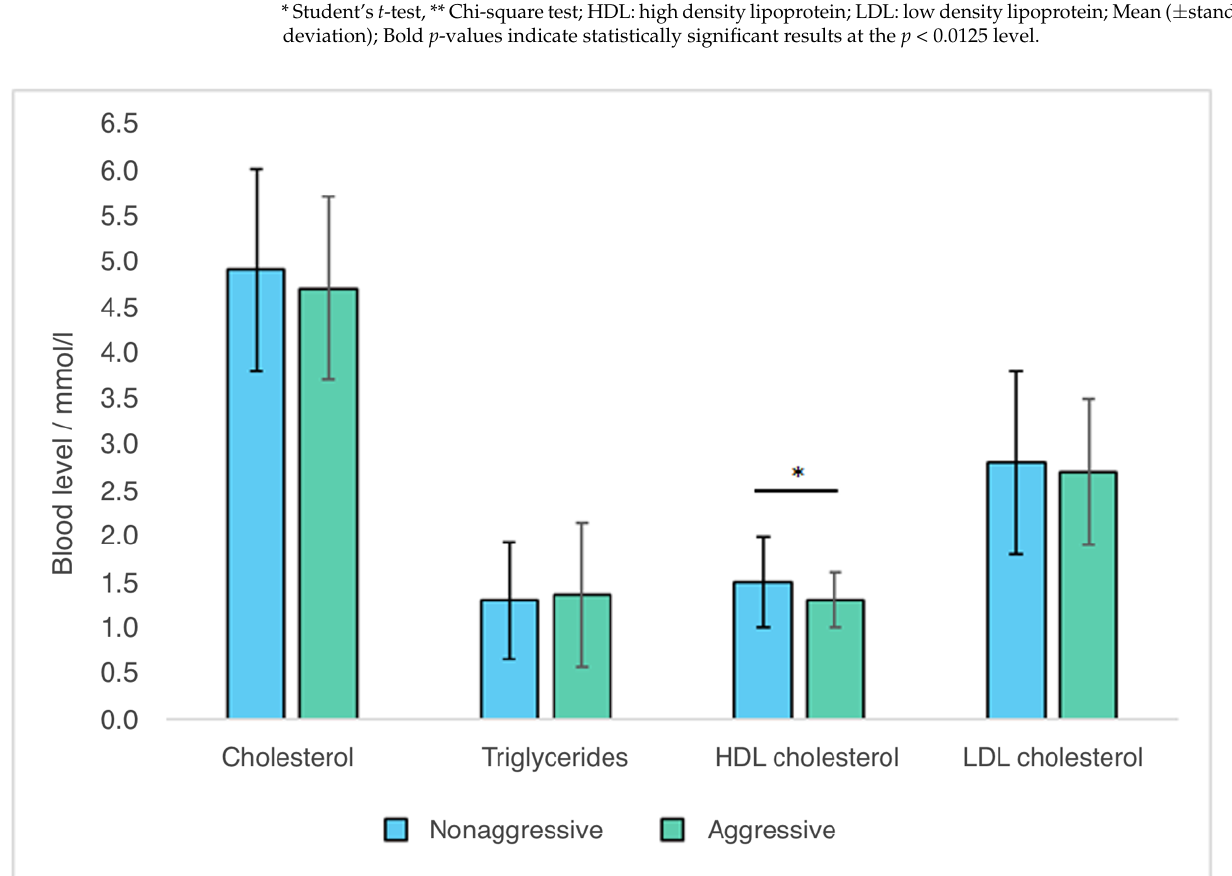
Figure 1. Relationship between the values of metabolic parameters and aggression in subjects with schizophrenia. Data are presented as mean ± standard deviation (SD); * p = 0.012 vs. HDL cholesterol concentration in nonaggressive subjects, Student ’s t -test.